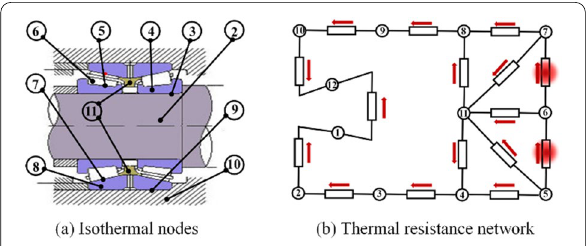
Figure 1 Bearing isothermal node division and heat transfer paths